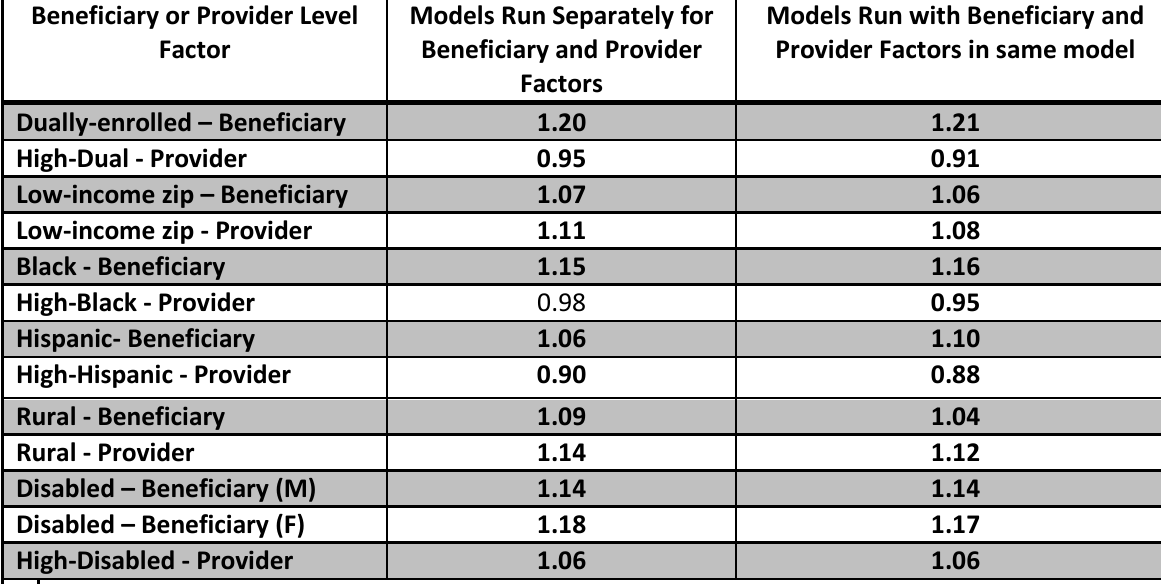
Table 13.9b: Beneficiary versus Provider Factors in ED Use Beneficiary or Provider